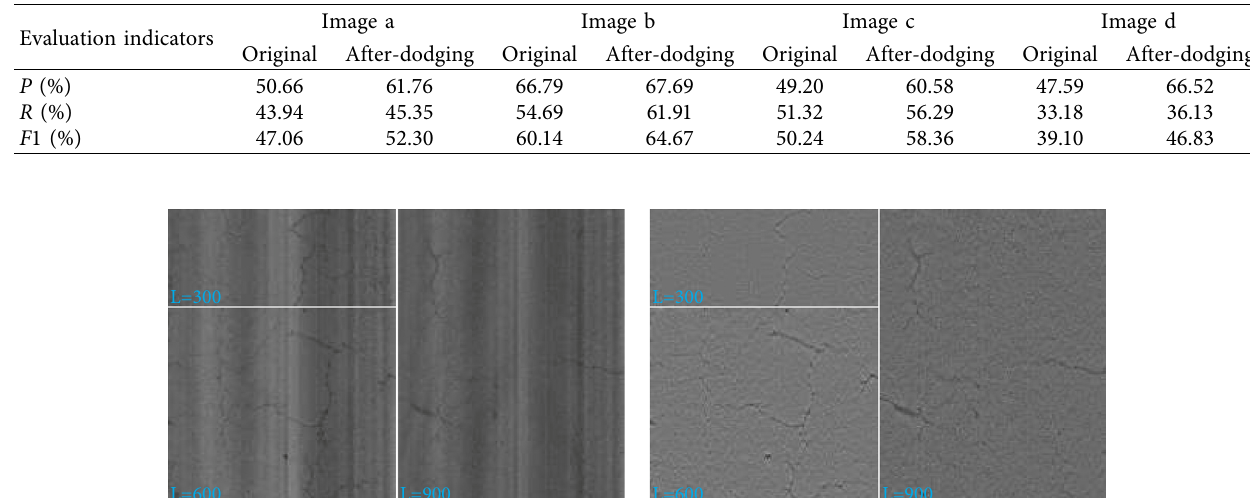
Table 3: Comparison of crack segmentation results.